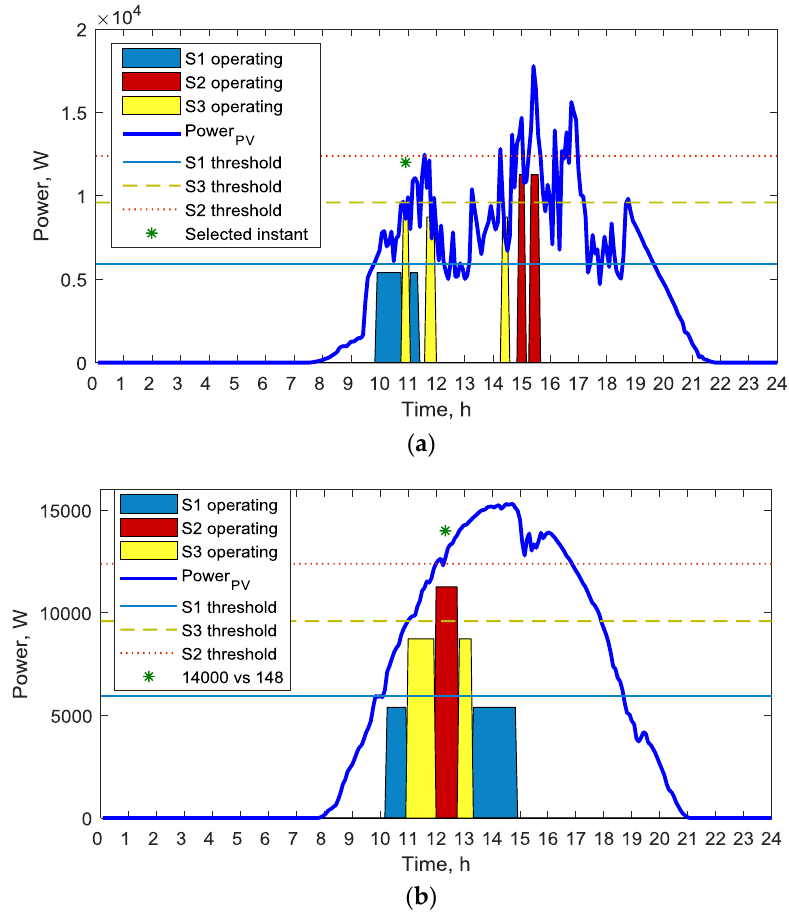
Figure 7. Photovoltaic power generation, power threshold and operation sequence of sectors of the irrigation network in the Julian day of the year 106 ( a ) and 209 ( b ) of the irrigation seasons. Two different times of the day were selected in Figure 7a,b (red asterisk), 11 am and 12 am, respectively. For both selected time periods, RESSIM GUI is shown in Figure 8a,b respectively. S3